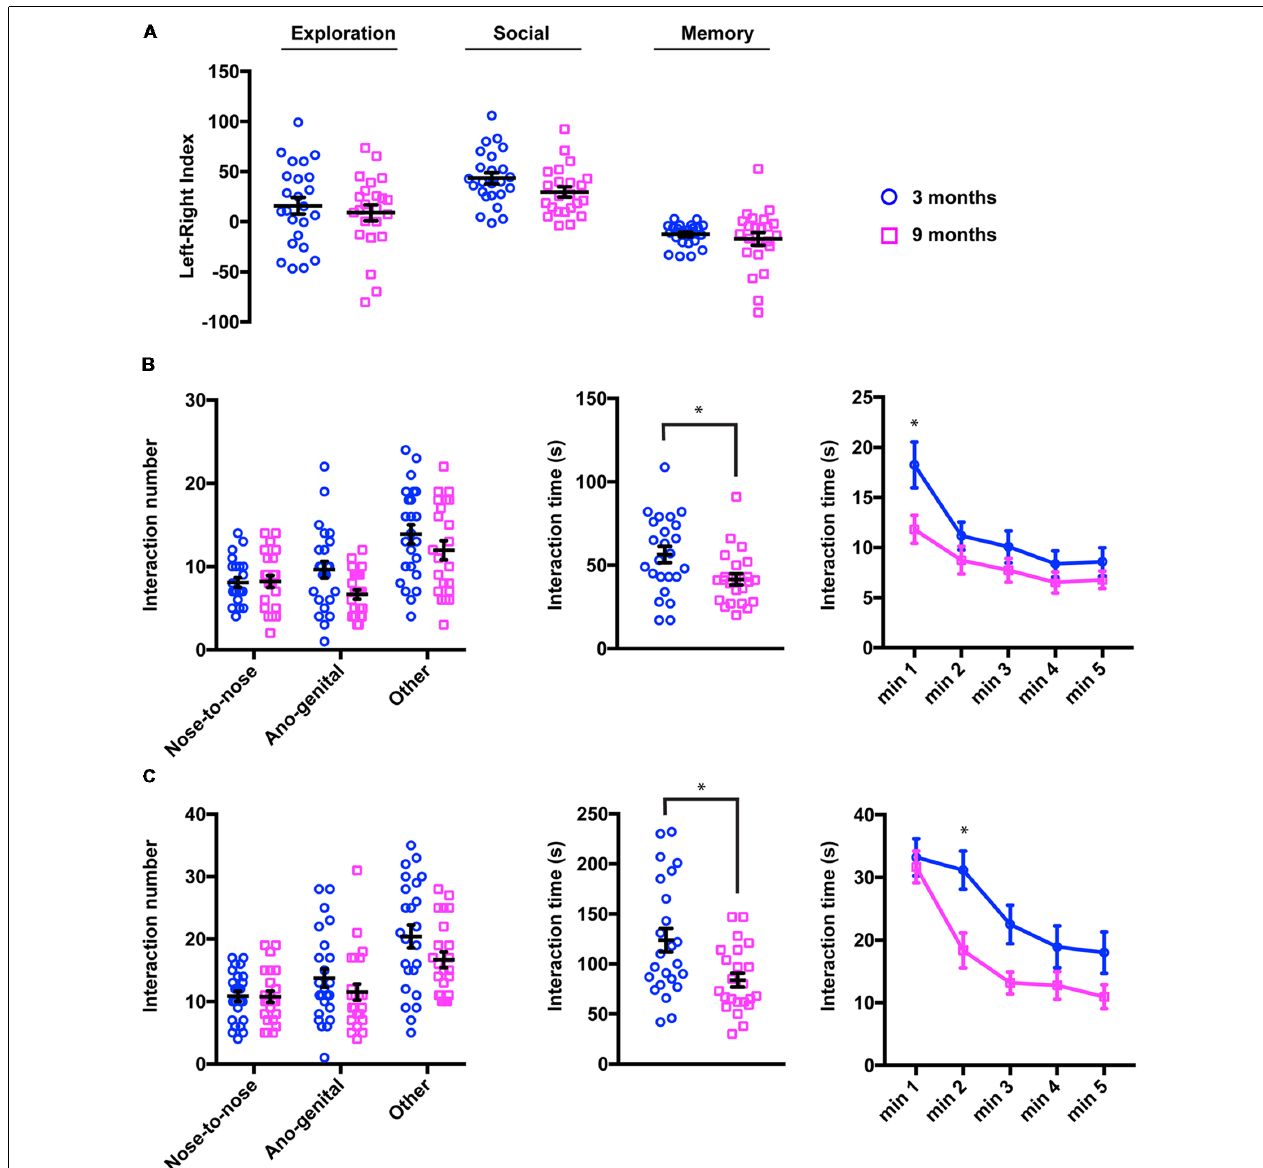
FIGURE 4 | Social drive/sociability is specifically disrupted in 9-month-old mice. (A) In the three-chamber apparatus, the mice spent the same amount of time exploring empty objects (exploration trial) or the social partners (social and memory phases) regardless of their age. For quantification, a left-right index (LRI) was calculated (see “Materials and Methods” section; 3 months, LRI exploration 16.03 ± 8.28, LRI exploration 29.76 ± 5.06, LRI social − 12.67 ± 2.26; 9 months, LRI social 9.00 ± 7.96, LRI memory 43.36 ± 5.47, LRI memory − 17.13 ± 6.40). (B) Quantification of social interactions initiated by 3- and 9-month-old mice in a novel arena containing a juvenile male (3–5 week-old). Although the number and type of interactions (left panel; 3 months, Nose-to-nose 8.08 ± 0.56, Ano-genital 9.62 ± 1.02, Other, 13.87 ± 1.14; 9 months, Nose-to-nose 8.22 ± 0.72, Ano-genital 6.65 ± 0.56, Other, 11.96 ± 1.14) showed no difference between the two groups, the total time spent interacting was significantly lower in elderly mice (middle panel; 3 months, 56.46 ± 4.84 s; 9 months, 41.61 ± 3.36 s, ∗ p = 0.0196, Kolmogorov-Smirnov test). When the interaction time was analyzed at 1-min intervals (right panel), most of the reduction was observed in the 1st min of the exploration phase (3 months, Minute 1 18.25 ± 2.28 s, Minute 2 11.16 ± 1.38 s, Minute 3 10.08 ± 1.60 s, Minute 4 8.37 ± 1.31 s, Minute 5 8.58 ± 1.40 s; 9 months, Minute 1 11.82 ± 1.39 s, Minute 2 8.74 ± 1.37 s, Minute 3 7.74 ± 1.19 s, Minute 4 6.52 ± 1.05 s, Minute 5 6.78 ± 0.86 s). ∗ p minute1 = 0.009 [2 way analysis of variance (ANOVA), Sidak test]. (C) In the intruder test, the number and type of interactions (left panel; 3 months, Nose-to-nose 10.83 ± 0.83, Ano-genital 13.75 ± 1.48, Other, 20.42 ± 1.82; 9 months, Nose-to-nose 10.78 ± 0.91, Ano-genital 11.52 ± 1.30, Other, 16.70 ± 1.25) were not altered in 9-month-old mice compared to 3-month-old animals. In contrast, the total time spent interacting was significantly lower in older mice (middle panel; 3 months, 123.8 ± 11.72 s; 9 months, 83.91 ± 6.84 s, ∗ p = 0.0496, Kolmogorov-Smirnov test). At 1 min intervals (right panel), the 9-month-old mice showed no change in the exploration phase (first minute), but a significant decrease in social afterwards (3 months, Minute 1 33.20 ± 2.97 s, Minute 2 31.17 ± 3.04 s, Minute 3 22.50 ± 3.07 s, Minute 4 18.92 ± 3.43 s, Minute 5 18.00 ± 3.30 s; 9 months, Minute 1 31.70 ± 2.53 s, Minute 2 18.34 ± 2.79 s, Minute 3 13.17 ± 1.678 s, Minute 4 12.78 ± 2.22 s, Minute 5 10.96 ± 1.92 s). ∗ p minute2 = 0.006 (2-way ANOVA, Sidak